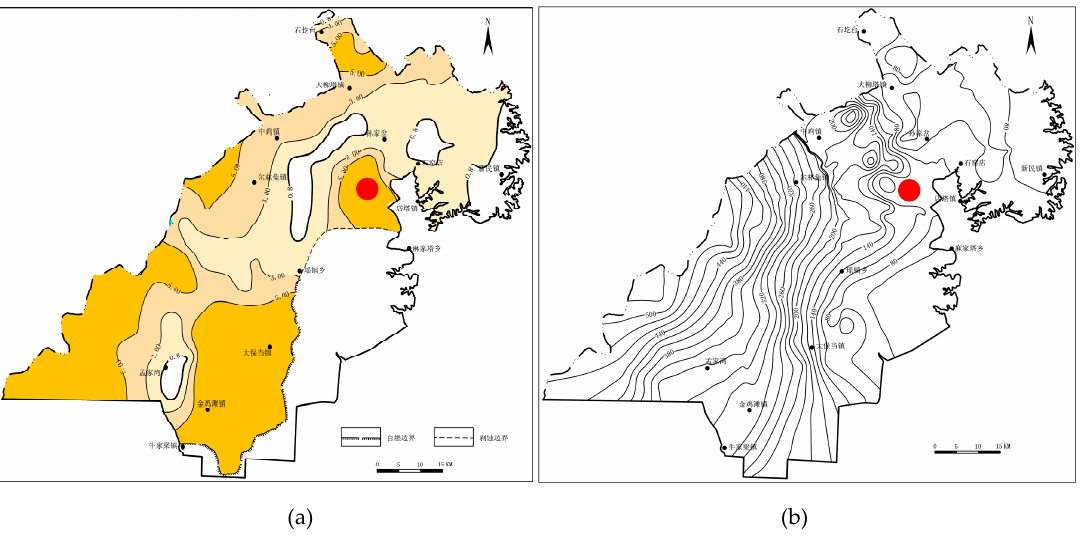
Figure 1. Occurrence feature of No.2-2 coal seam in Jurassic Coalfield in Shenfu mining area, China [2] : (a) the contour of thickness of No.2-2 coal seam; (b) the contour of depth of No.2-2 coal seam.